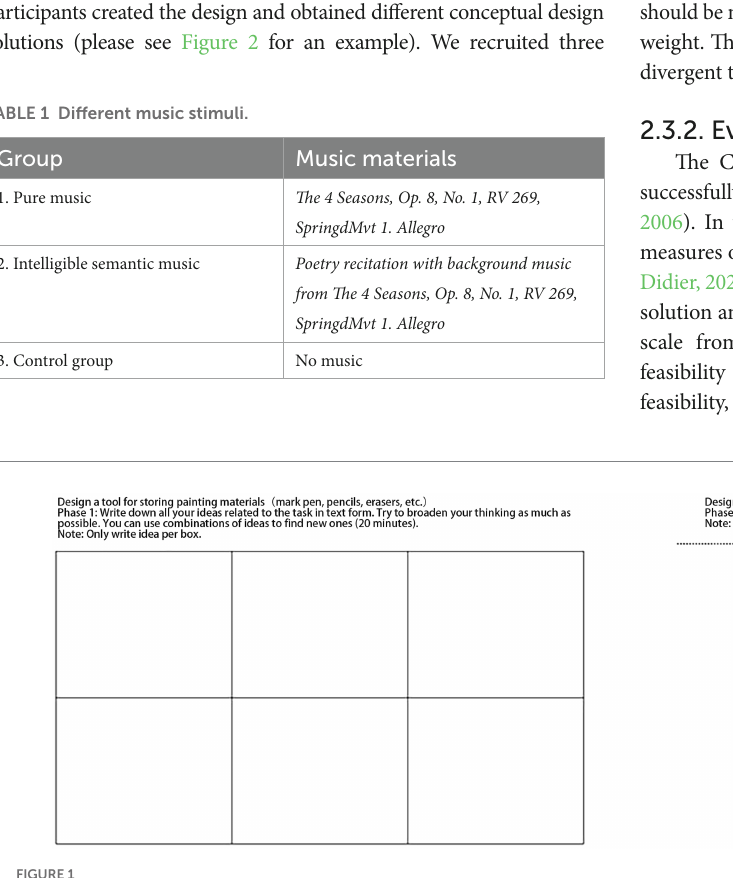
FIGURE 1 Design task. For phase 1, participates have 20 min to design a tool for storing painting materials. They were told to draw out as many of their ideas as possible. For phase 2, participants were asked to choose the most innovative idea and then refine it by sketching it out. Participates had 20 min for this